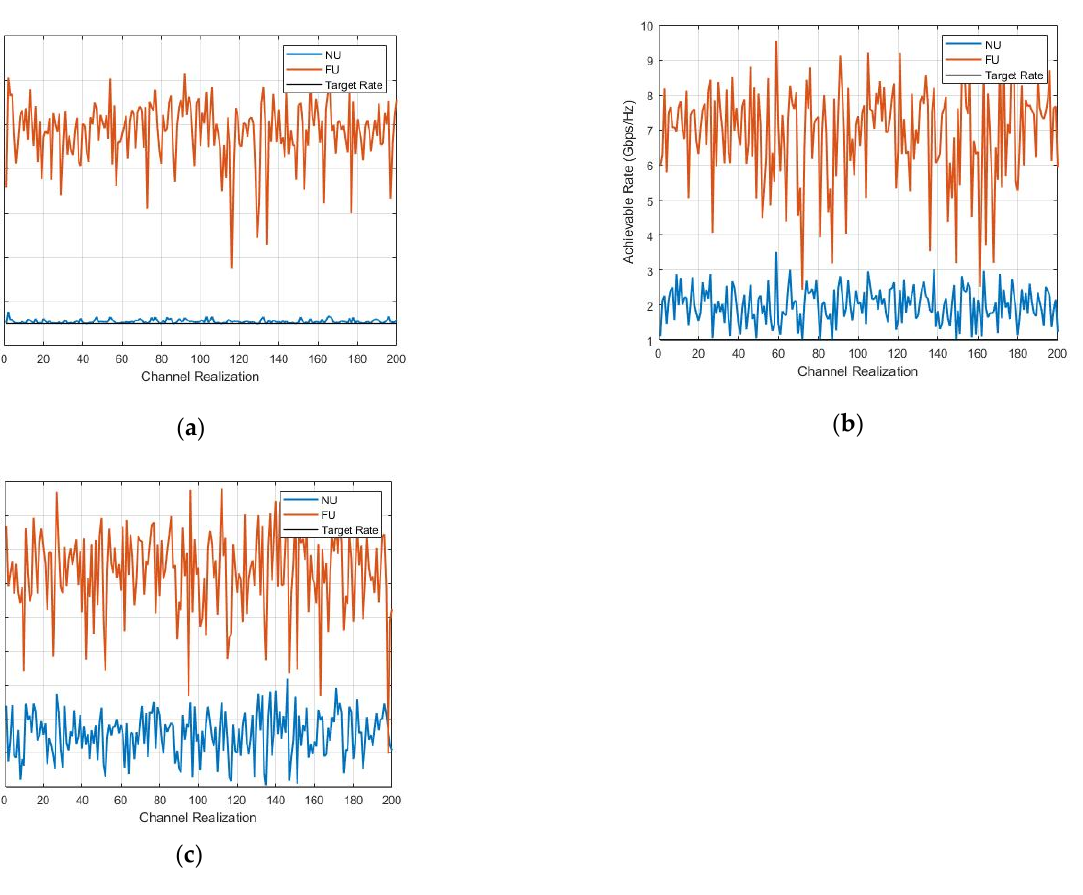
Figure 8. Instantaneous-rate versus channel-realization.